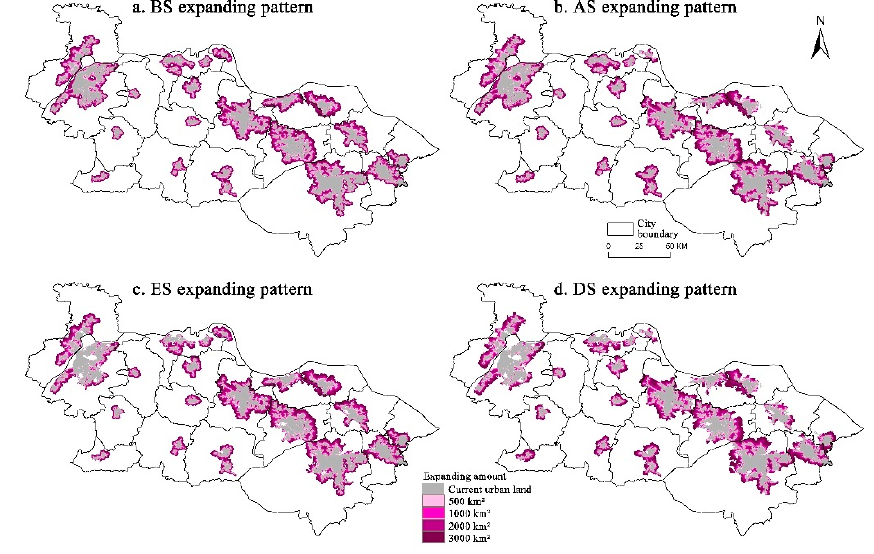
Figure 7. USE pattern under four scenarios.